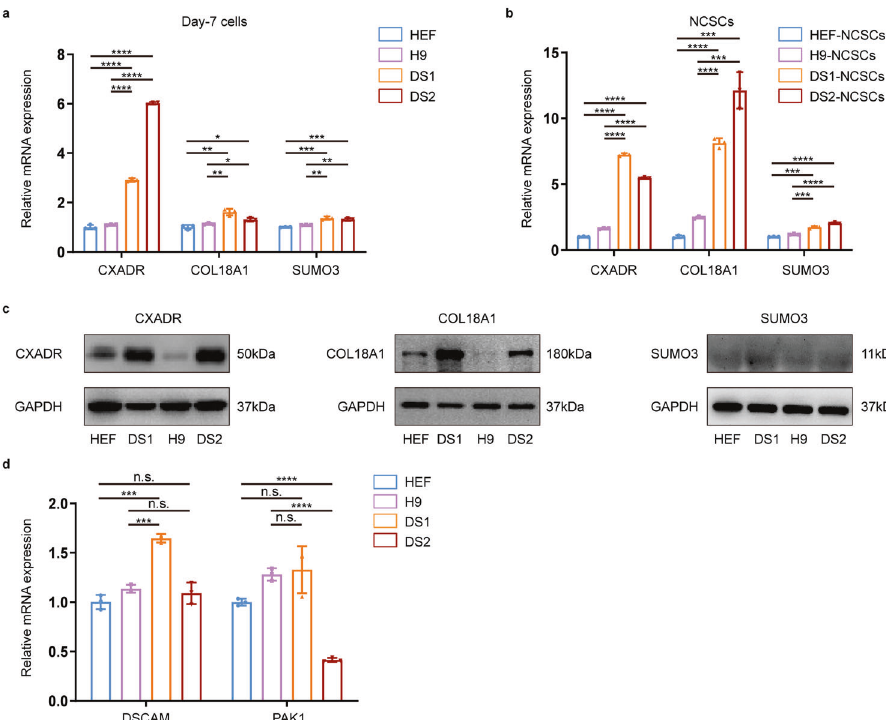
Fig. 5 The expression of CXADR, COL18A1, and SUMO3 was upregulated in DS-NCSCs compared to control NCSCs. a qPCR assay for CXADR, COL18A1, and SUMO3 expression in day 7 cells before FACS enrichment. b qPCR assay for CXADR, COL18A1, and SUMO3 expression in p75 high /HNK1 + NCSCs enriched by FACS. c The protein level of CXADR, COL18A1, and SUMO3 in DS and control cells was detected by western blotting. d qPCR assay for the mRNA expression of DSCAM and PAK1. Data are presented as the mean ± SD of three